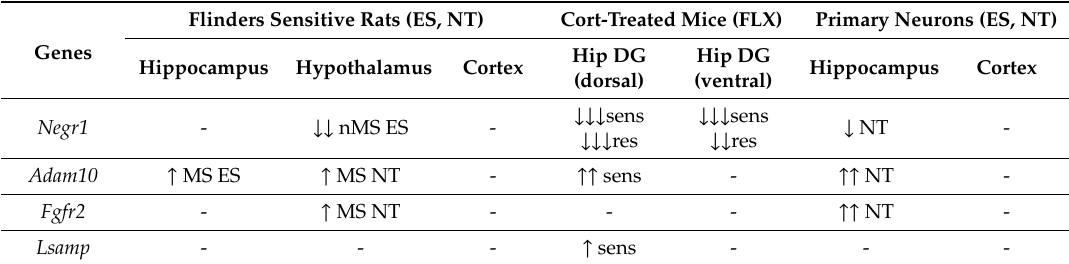
Table 1. Overview of the direction of gene expression modulation exerted by chronic antidepressant treatments for genes belonging to the Negr1-Fgfr2 pathway. Cort: corticosterone; Flx: fluoxetine; sens: fluoxetine-sensitive; res: fluoxetine resistant; Hip DG: hippocampal dentate gyrus. Flinders Sensitive Rats (ES,